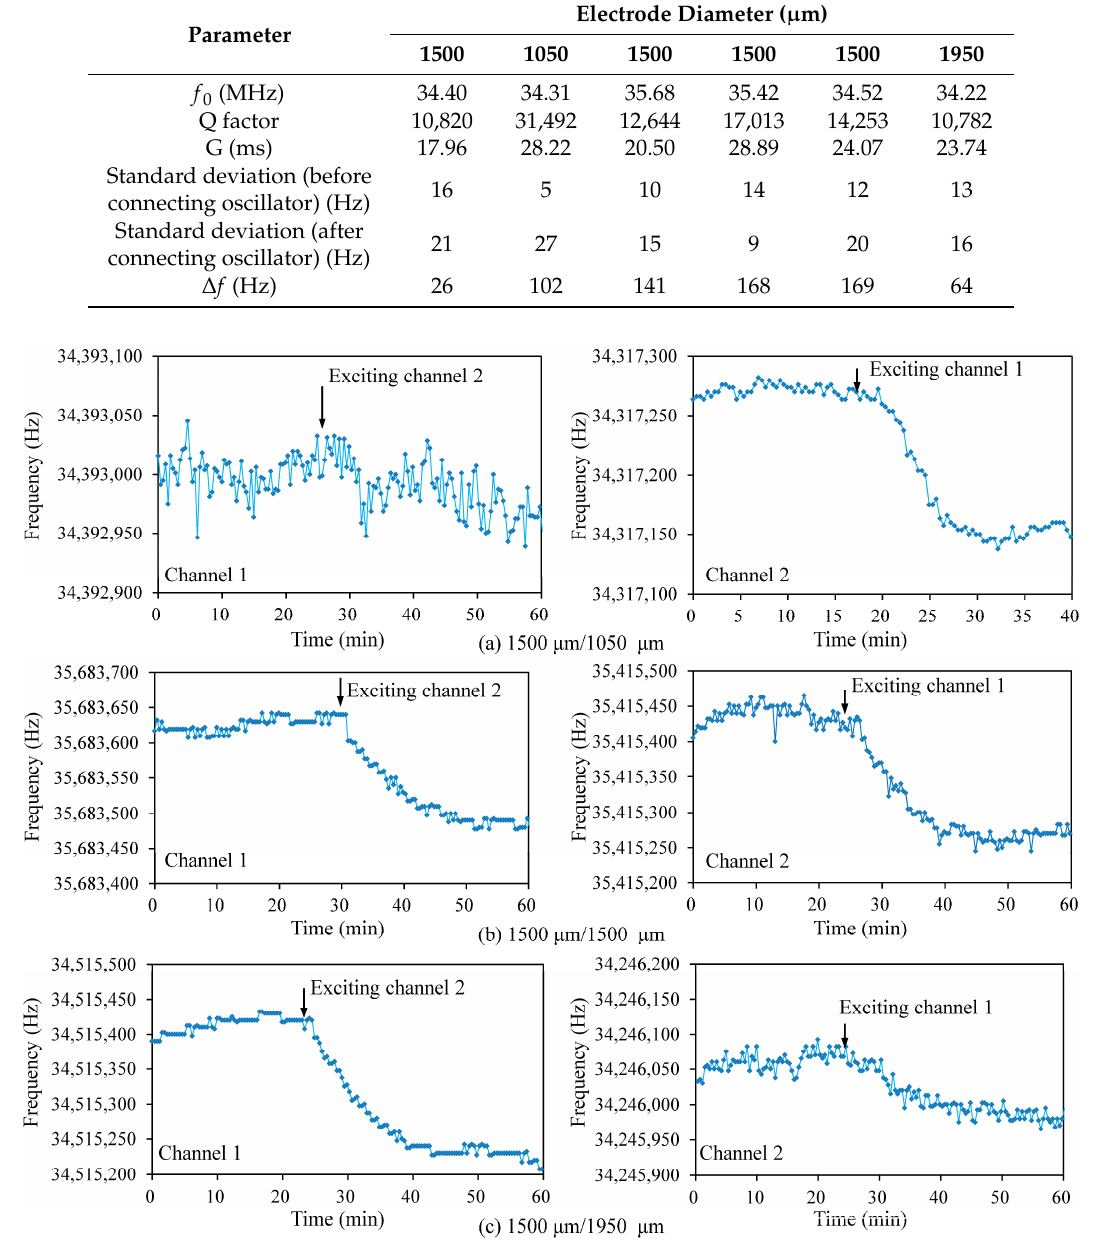
Figure 4. Measured frequency interference between two channels.